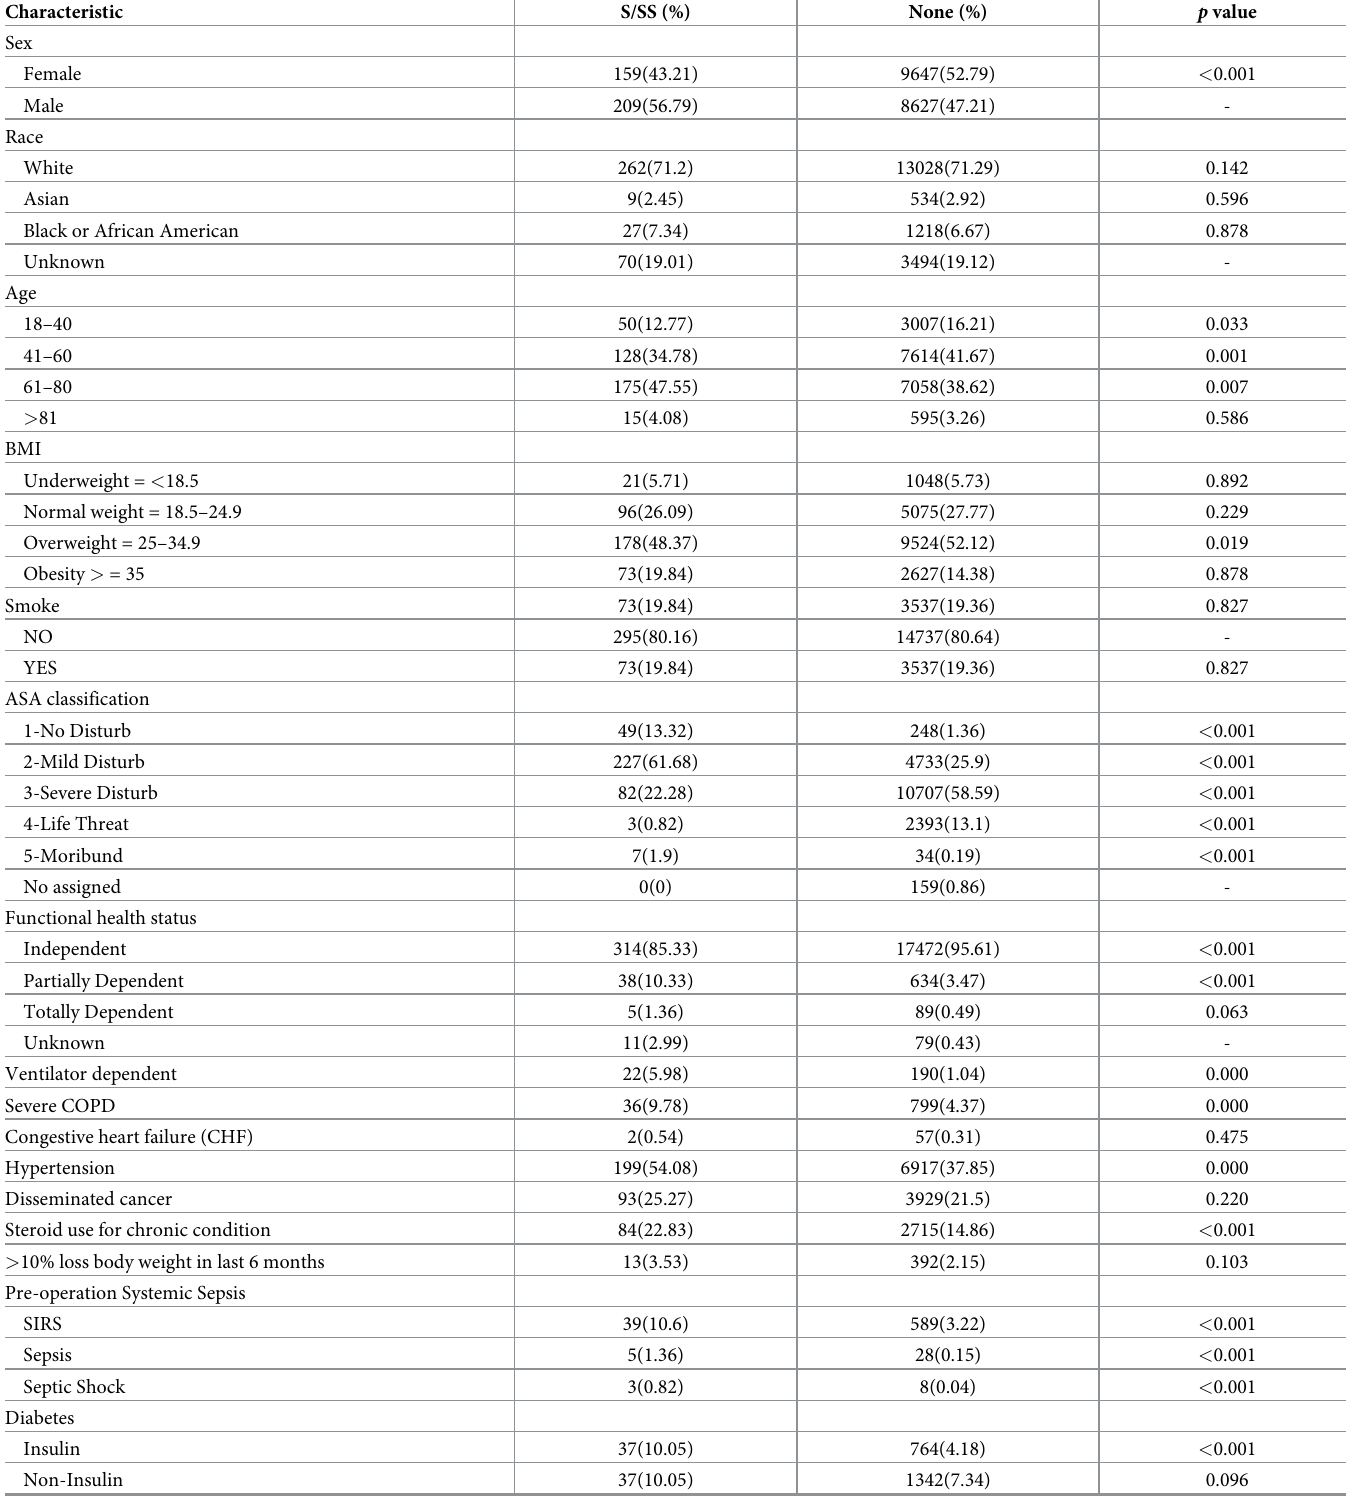
Table 2. Sepsis and septic shock events and 30-day mortality